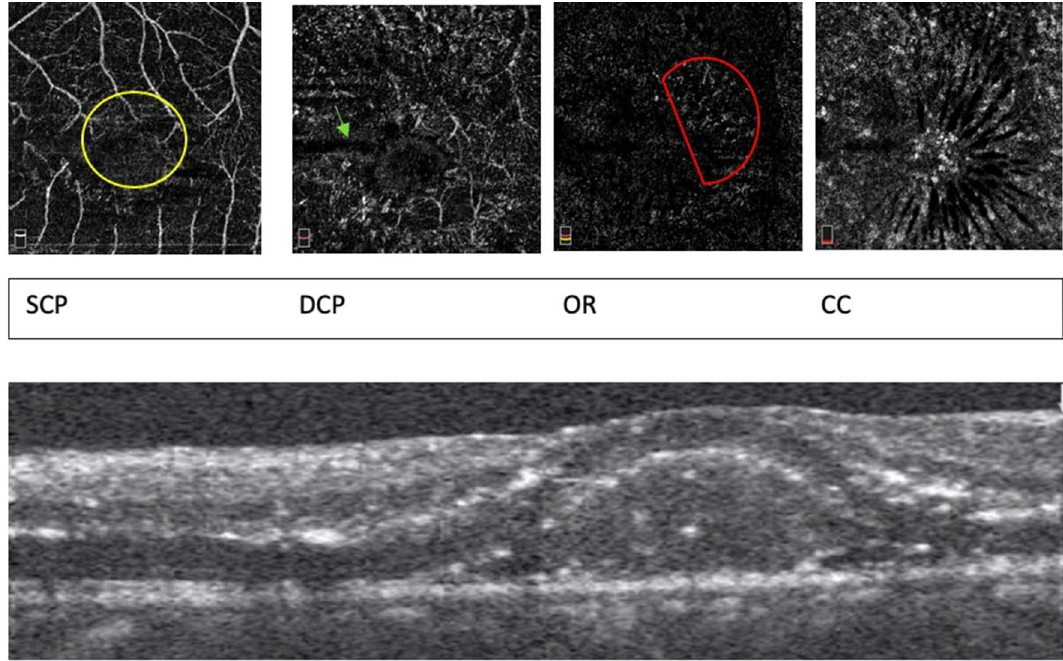
Figure 4. (Patient 33) OCTA: 3 mm × 3 mm scans of SCP, DCP, OR and CC layers. SCP: Extensive capillary rarefaction in between larger vessels and gross distortion of the FAZ landmarks owing to the significant oedema. (yellow circle). DCP: Projection artefacts with poor demarcation of finer vascular network and a totally lost FAZ due to intraretinal oedema (green arrow). Avascular areas of FAZ showing HR brighter areas due to suspending particle artifacts. OR: Few areas of brighter areas due to the overlying projection artifacts. (red D). CC: Changes in the coarse architecture. Radial striations well delineated due to the oedema in Henle’s layer. OCT: